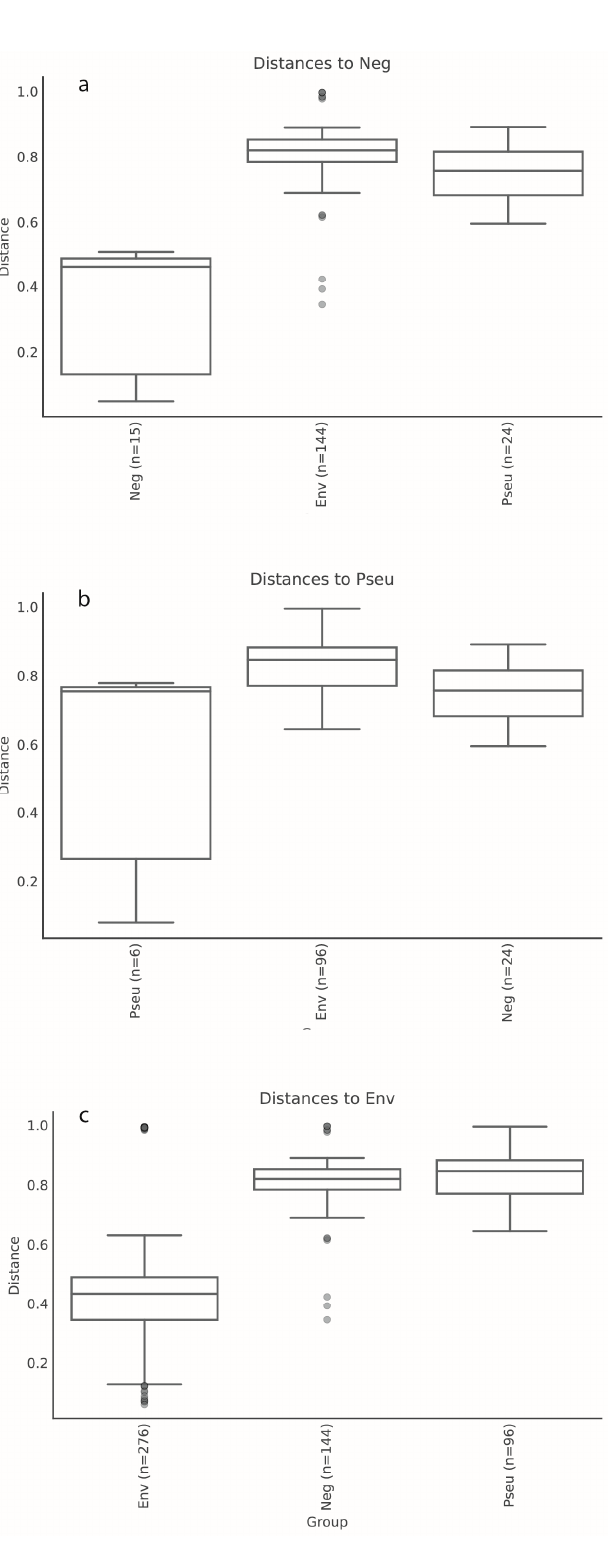
Figure 3. Bray-Curtis distance between different inoculum types from the last two time-points combined. Median, interquartile range and outliers distances between all column samples and ( a ) non-inoculated (Neg) column distance ( b ) Pseudomonas aeruginosa (Pseu), and ( c ) Stormwater inoculated columns (Env). For each group, the left most comparison represents the within-group distances, and other comparisons are between-group comparisons. All pairwise comparisons between groups were statistically significantly different with both permanova and ANOSIM ( p -value ≤ 0.005).